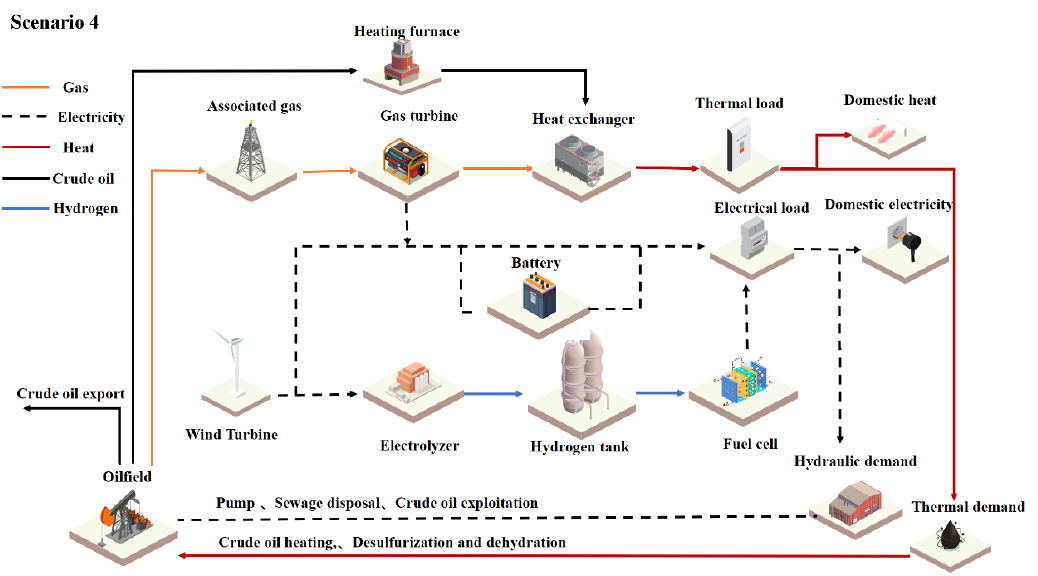
Figure 5. The oilfield energy system framework of scenario 4.